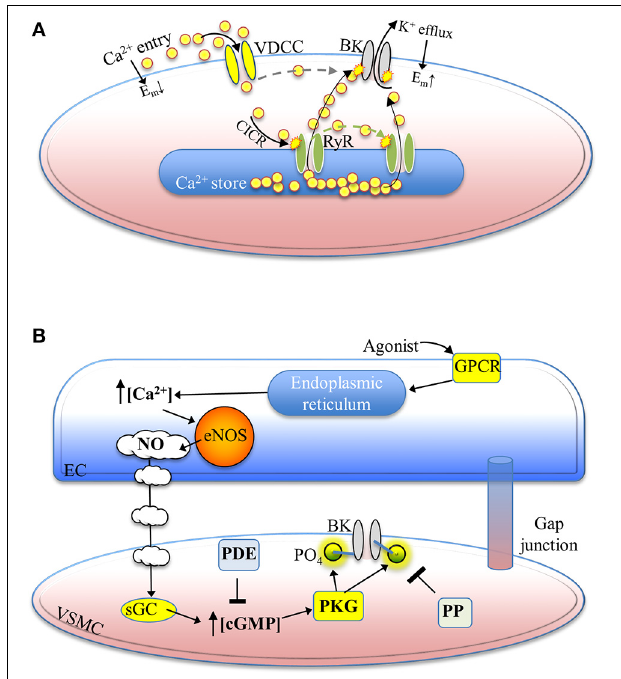
FIGURE 2 | A summary of select physiological mechanisms leading to BK channel activation and reversible phosphorylation-mediated enhancement. (A) Ca 2 + –dependent activation of BK channels hyperpolarizes the membrane potential. Depolarization of the membrane potential activates voltage-dependent Ca 2 + channels, leading to Ca 2 + entry and Ca 2 + -induced Ca 2 + release from nearby ryanodine receptors. Released Ca 2 + promotes BK channel activation, which drives the membrane potential in the negative (hyperpolarized) direction. Ca 2 + influx via VDCCs may also contribute directly to BK channel activation (dotted line) as a result of the spatial proximity of these two channels within membrane nano/micro-domains. (B) Mechanisms underlying the generation of nitric oxide from an endothelial cell, with the NO/cGMP/PKG-mediated phosphorylation of a BK channel illustrated in an adjacent vascular smooth muscle cell. Nitric oxide release from endothelial cells binds to soluble guanylyl cyclase in smooth muscle cells, resulting in elevated intracellular cGMP concentrations. PKG is then activated and phosphorylates the BK α subunit. Phosphodiesterase activity lowers intracellular cGMP and protein phosphatase activity removes the regulatory phosphate from Ser/Thr residues of the BK channel protein. Abbreviations: VDCC, voltage-dependent Ca 2 + channel; BK, BK channel; E m , membrane potential; CICR, Ca 2 + -induced Ca 2 + release; RyR, ryanodine receptor; GPCR, GTP-binding protein-coupled receptor; eNOS, endothelial nitric oxide synthase; NO, nitric oxide; EC, endothelial cell; sGC, soluble guanylyl cyclase; PDE, phosphodiesterase; PO 4 , phosphate group; cGMP, cyclic guanosine monophosphate; PKG, protein kinase G; PP, protein phosphatase; VSMC, vascular smooth muscle